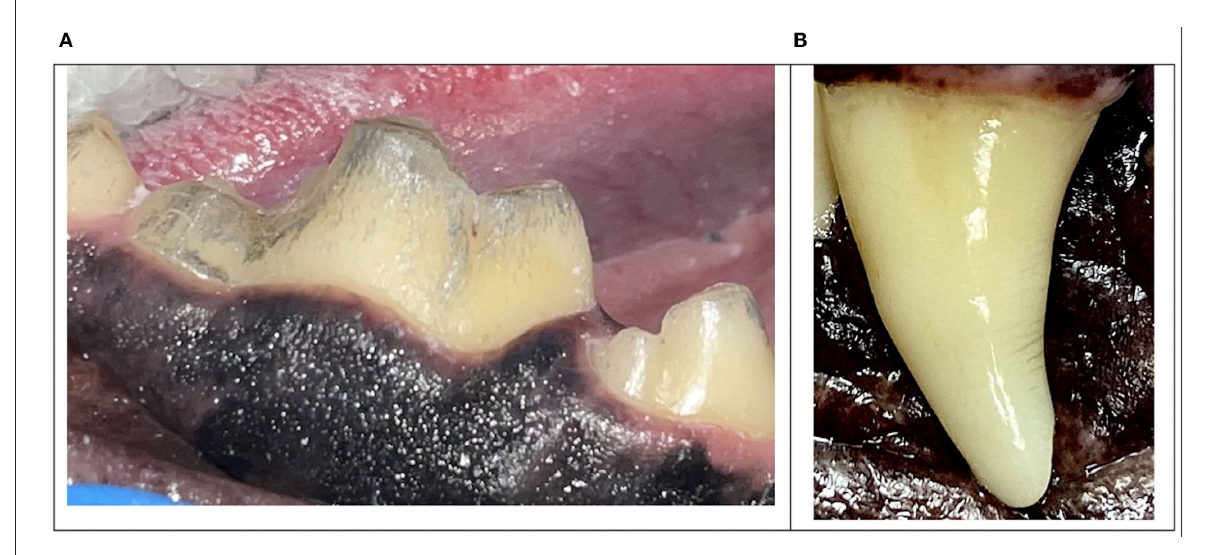
FIGURE10 Clinical photos of extrinsic metallic staining (A) and enamel infractions (B)